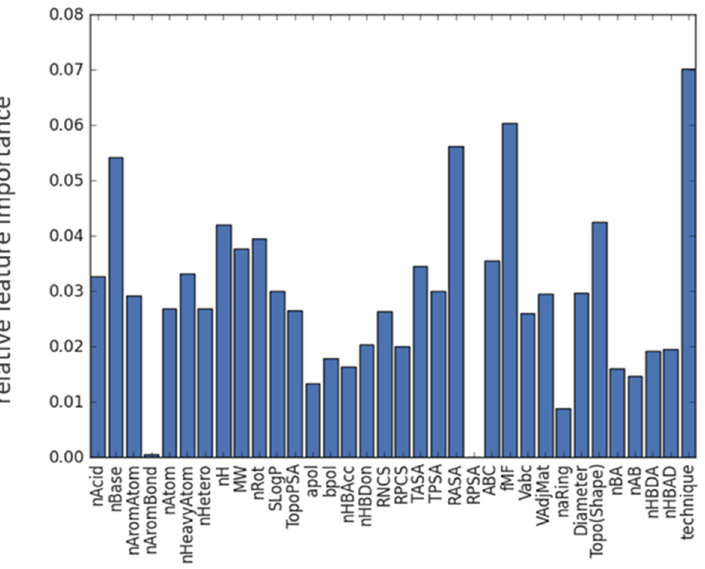
Figure 4. Feature importance plot highlighting the relative contribution of each descriptor (see Table 1) to the overall prediction averaged over ten training runs. Table 1) to the overall prediction averaged over ten training